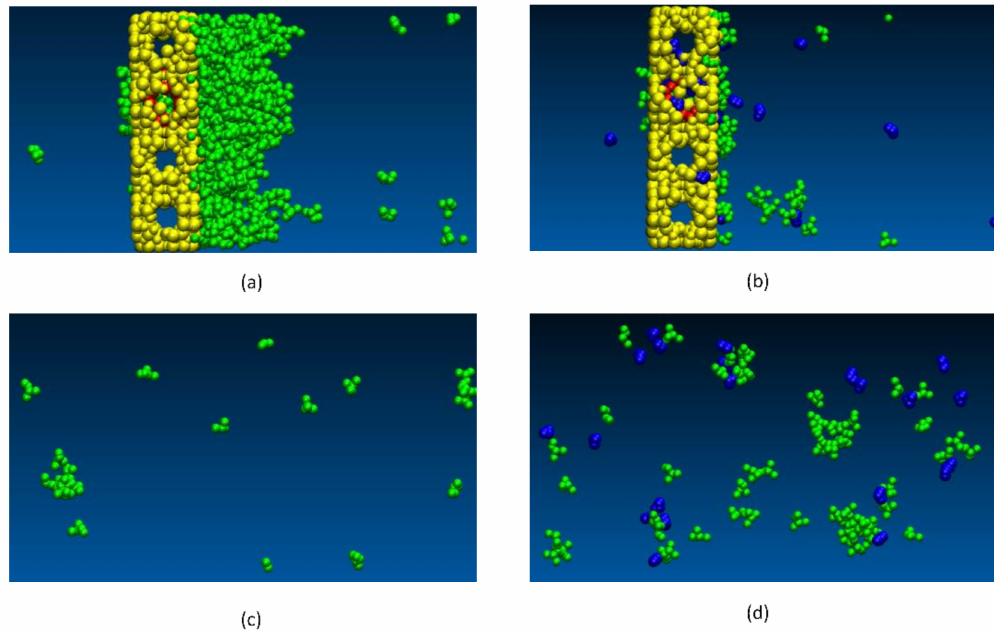
Figure 16. Differences in the observed behavior of the vapor phase when water is present: ( a ) snapshot of the pure IPA system near the zeolite membrane; ( b ) snapshot of system with 5 wt % water in vapor phase near the zeolite membrane. ( c ); snapshot of the pure IPA system away from membrane; ( d ): snapshot with 5 wt % water in vapor phase away from membrane; Key: yellow zeolite membrane; green IPA; and blue water; red: membrane